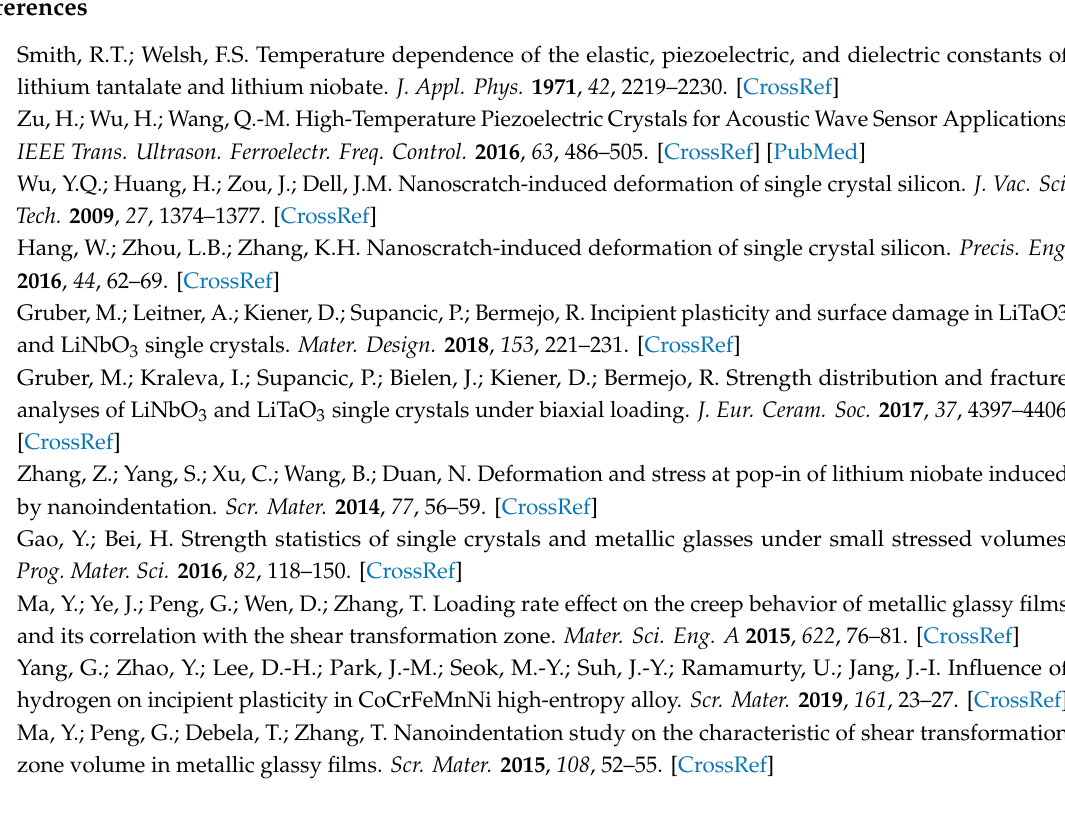
Figure S1: Schematic illustration of atomic arrangements for the typical orientations (a) X-112 ◦ , (b) Y-36 ◦ , and (c) Y-42 ◦ in LiTaO3 single crystal, and their surface morphologies by optical